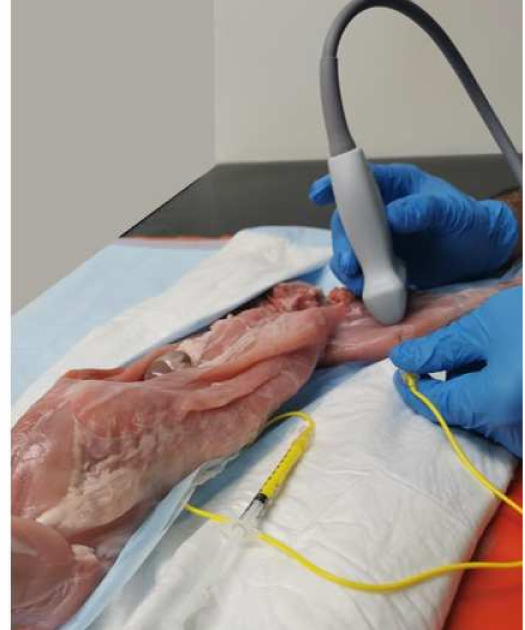
Figure 2. Representation of the position of the ultrasound transducer over the medial aspect of the middle of the thigh, transversally to the long axis of the pelvic limb. The probe is positioned with the marker caudally to visualize the saphenous